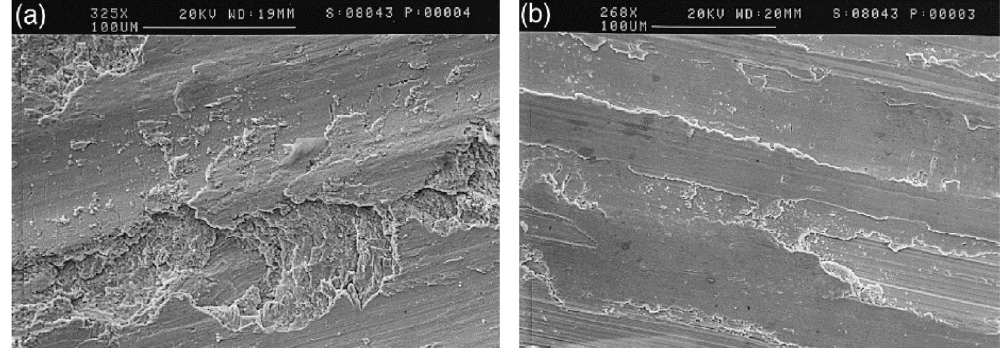
Fig. 23 Worn-out surfaces of Ti64 test specimen slid against AISI M2 steel counter-body at varying sliding velocities (load = 100 N): (a) Ti64 pin surface ensuing sliding at 0.3 m·s − 1 ; (b) Ti64 pin surface ensuing sliding at 0.8 m·s − 1 . Reproduced with permission from Ref. [29]. Copyright Elsevier,